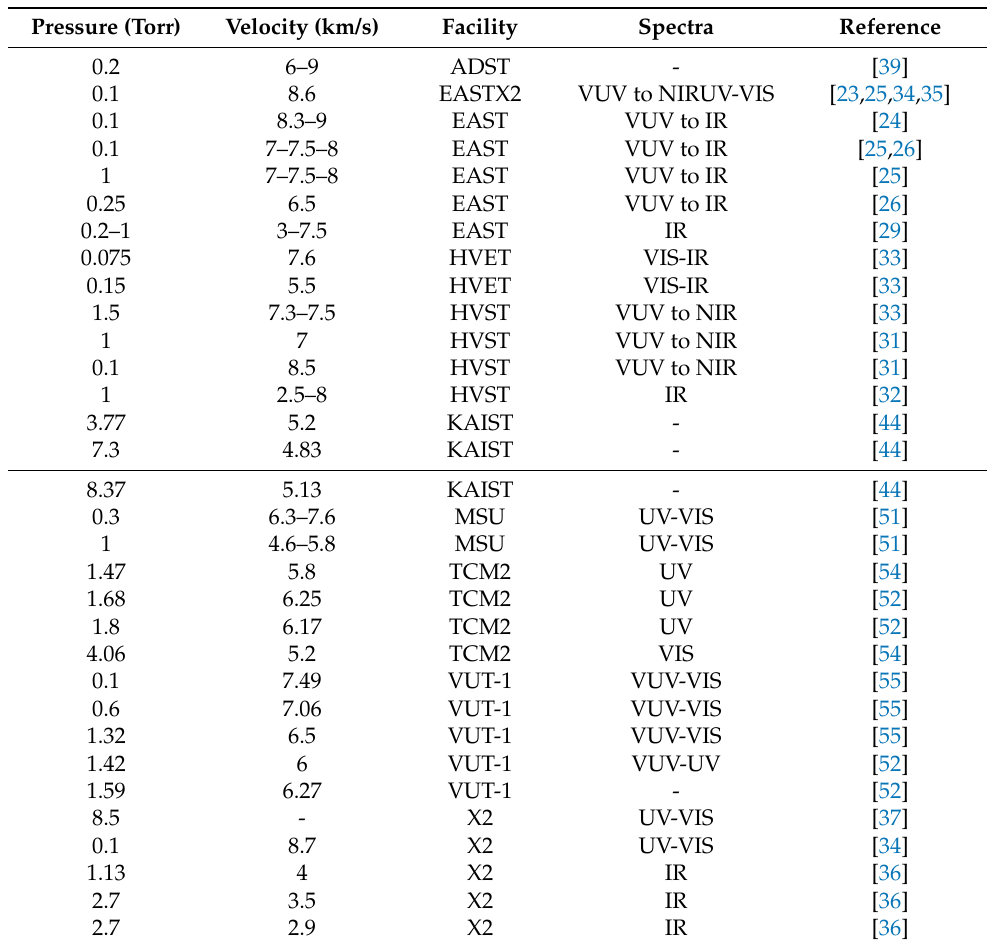
Table 8. Mars entry conditions investigated with shock facilities (shock-tubes, expansion tubes) experiments, with CO 2 -N 2 mixtures (for KAIST CO-N 2 ) related to Mars entry. In bold Test Case 2 (of Radiation Working Group)